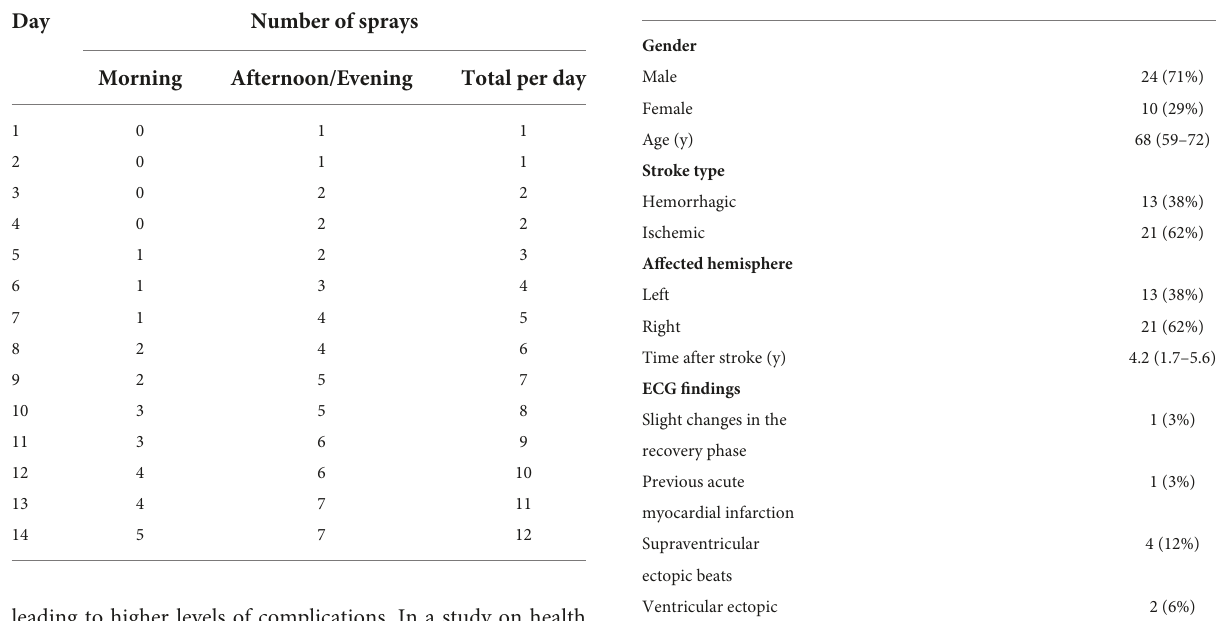
TABLE 1 Nabiximols titration scheme. TABLE 2 Baseline patient